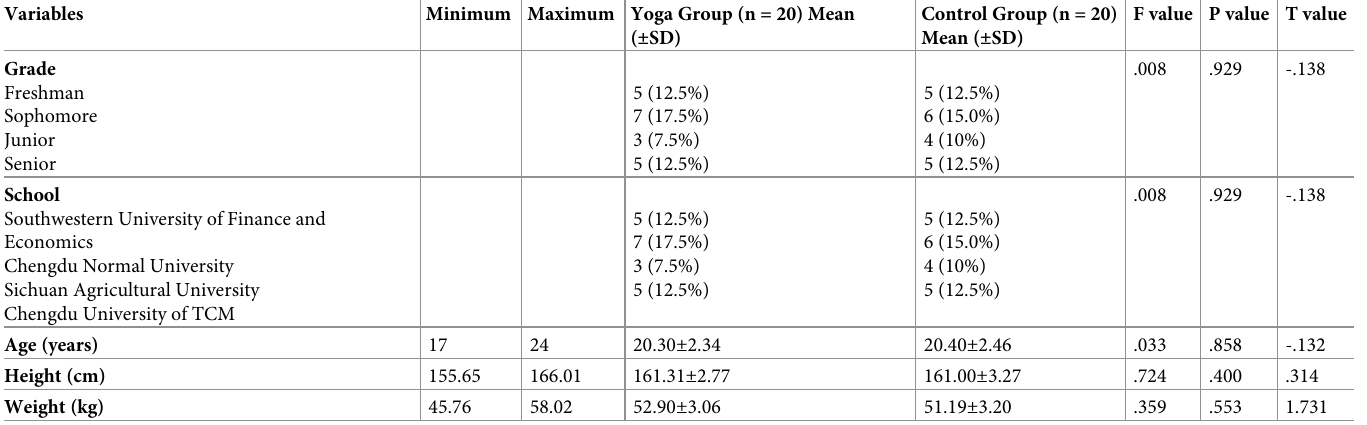
revealed a significant interaction between group and time of the single-limb stance test (F = 122.25, p < 0.05), with Cohen’s d of 2.59 for the pretest and posttest of the single-limb stance in the yoga group, and the effect size was 0.79, p < 0.05. Cohen’s d for the control group single-limb stance pretest and posttest was -0.14, and the effect size was -0.07, p > 0.05. Table 4 and Fig 3 show that there was a significant interaction between group and time for Romberg’s test (F = 133.91, p < 0.05), with Cohen’s d for Romberg pretest and posttest in the yoga group being 2.54 and effect size being 0.79, p < 0.05. Cohen’s d for the Romberg pretest and posttest in the control group was 0, and the effect size was 0, p > 0.05. The results suggest that yoga intervention can positively contribute to the balance ability of female college Table 3. Characteristics of the participants (n =